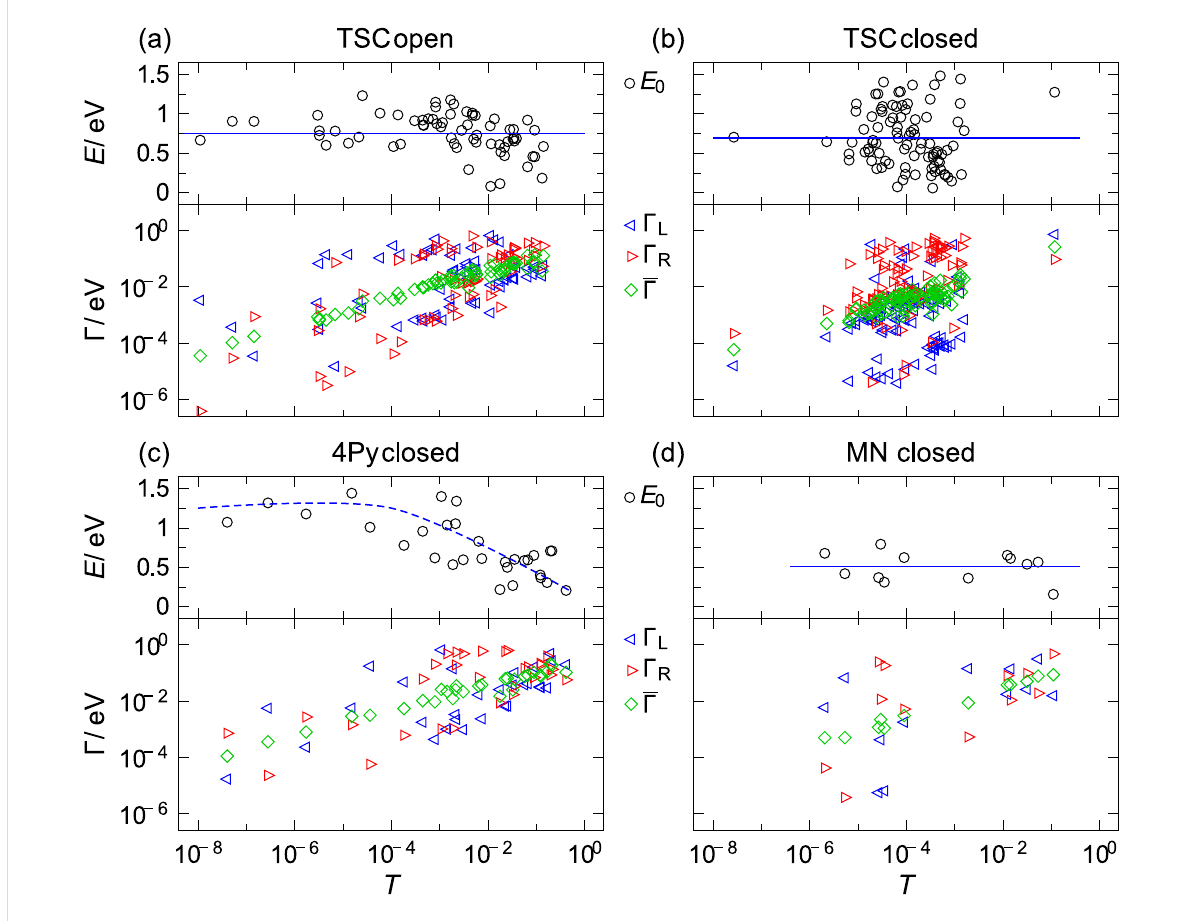
Figure 5: Fitting parameters Γ L and Γ R and | E 0 | for (a) open form of TSC, (b) closed form of TSC, (c) closed form of 4Py, and (d) closed form of MN as a function of transmission for asymmetric I – V 's.